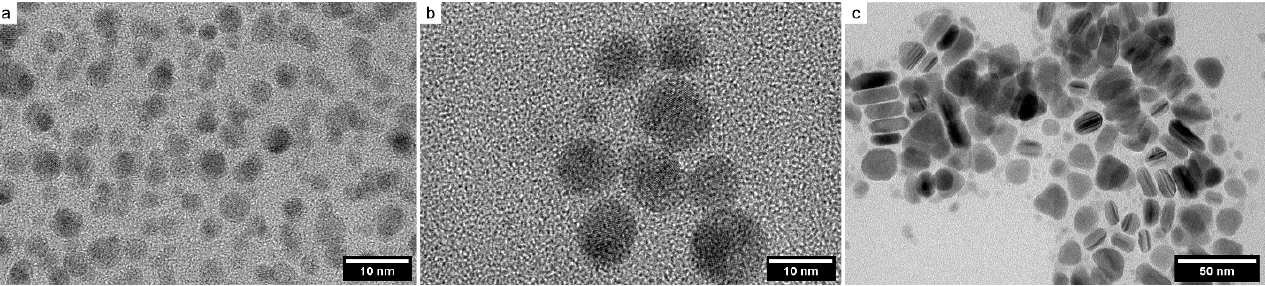
Table 1. The characteristics of silver NPs obtained from TEM and DLS technique.